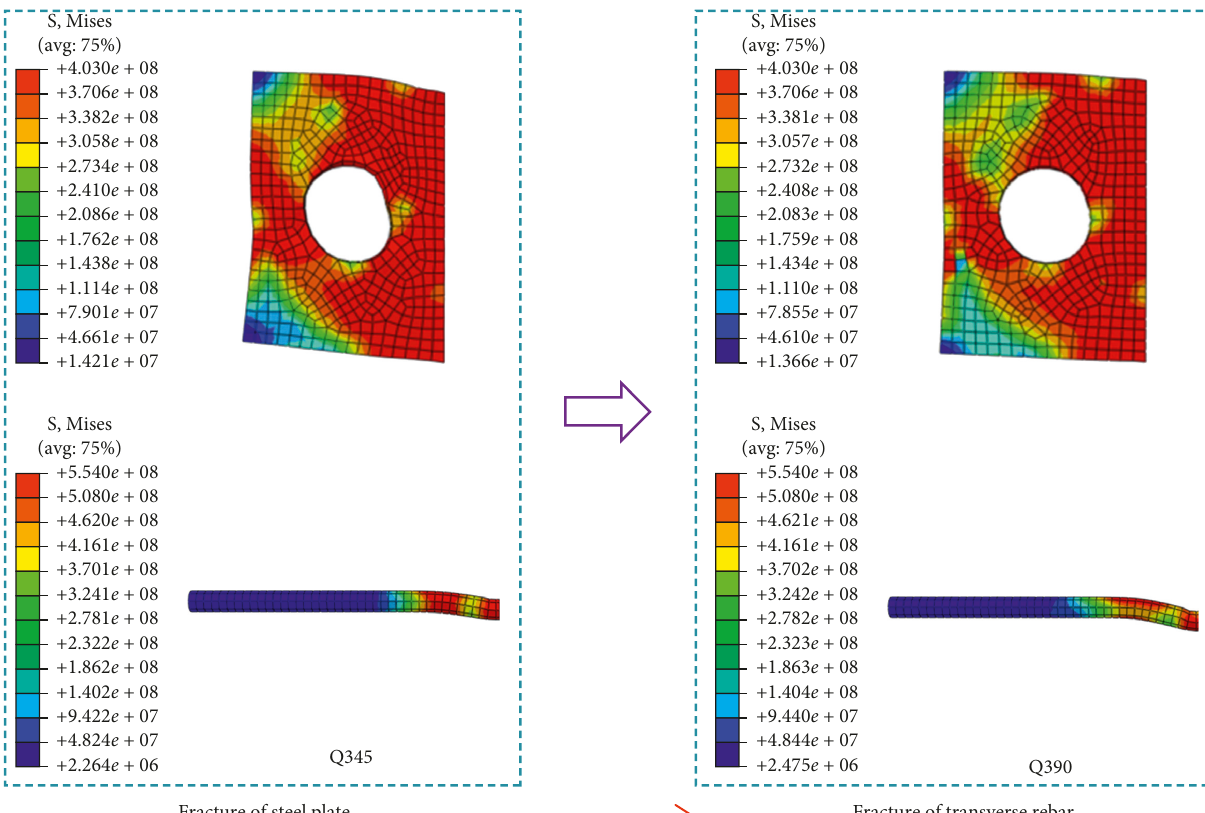
Figure 14: Failure patterns for PBL with different steel